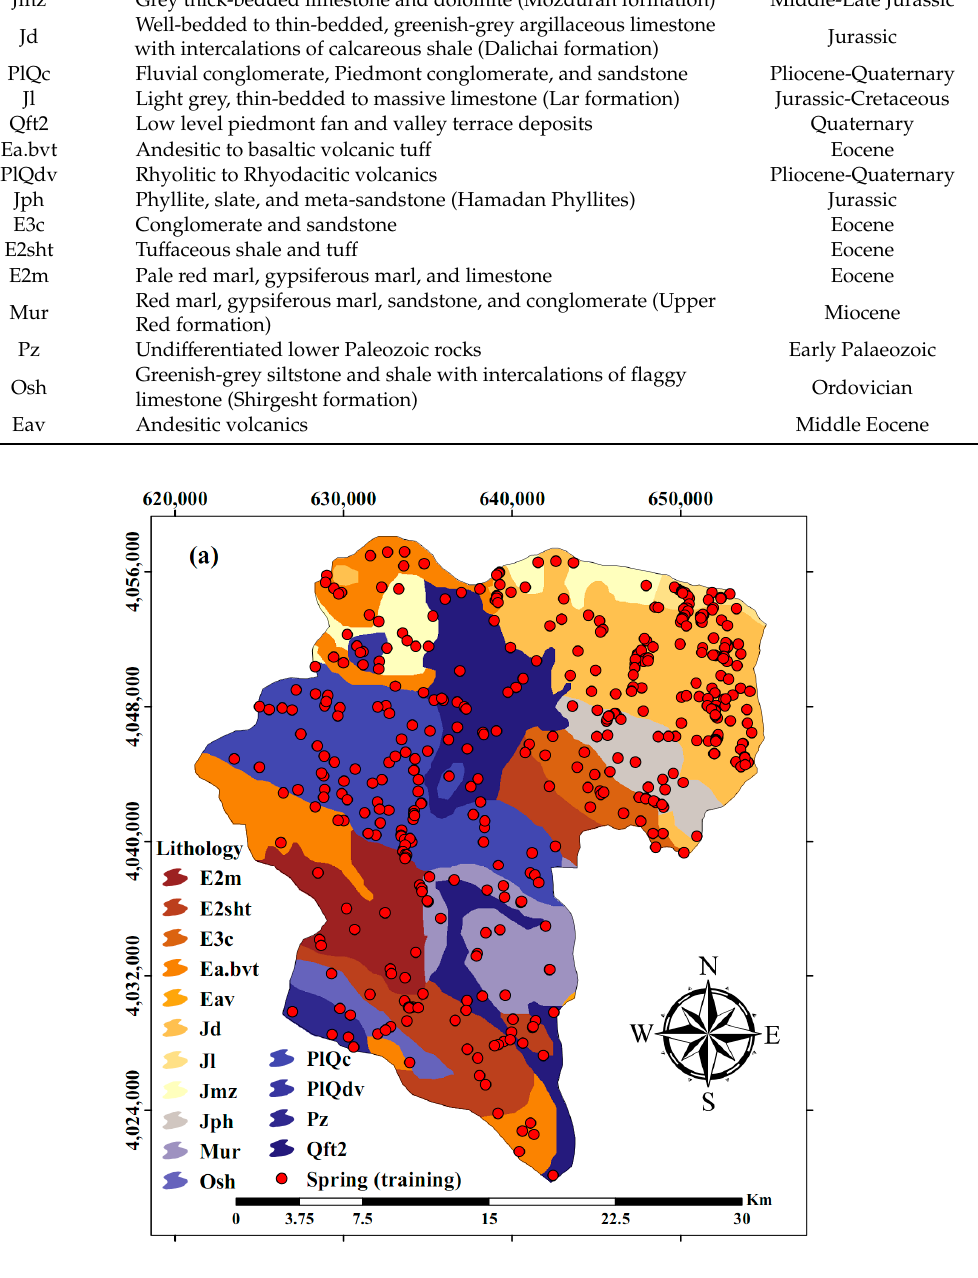
Figure 6. Lithology of the study area (symbols are de fi ned in Table 2).